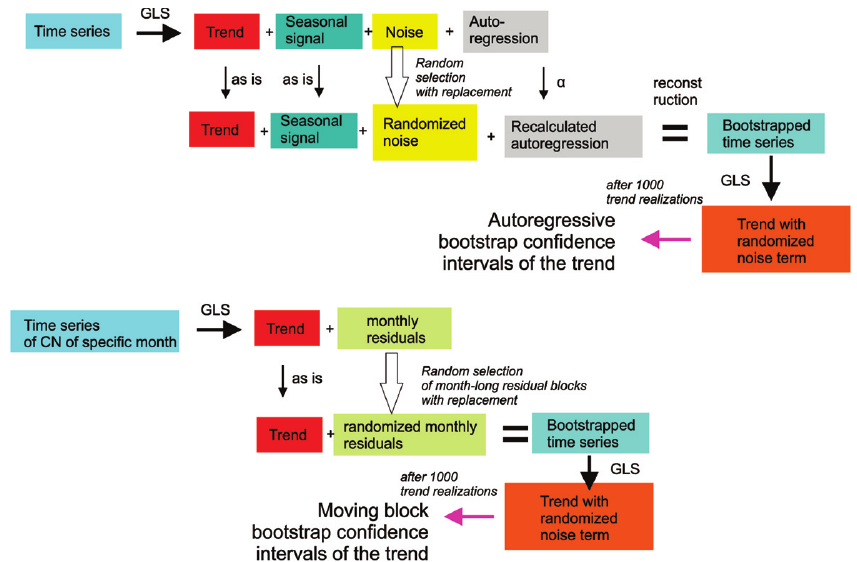
Fig. 1. Block diagram of GLS-ARB (above) and GLS-MBB (below) methods used for confidence interval generation. In the GLS-ARB, the time series is divided into trend, seasonal, autoregressive and noise parts. By randomly selecting the noise terms, and reconstructing the time series, another realization of the trend fitting can be made. From a number of these realizations, an ARB confidence interval is constructed. For trends of specific months, the GLS-MBB method randomly selected the residual term of the GLS fit in one-month long blocks (i.e. replacing the original residual with random year’s residual for the month in question). From these random realizations, a MBB confidence interval is constructed. The methods are adapted from Mudelsee